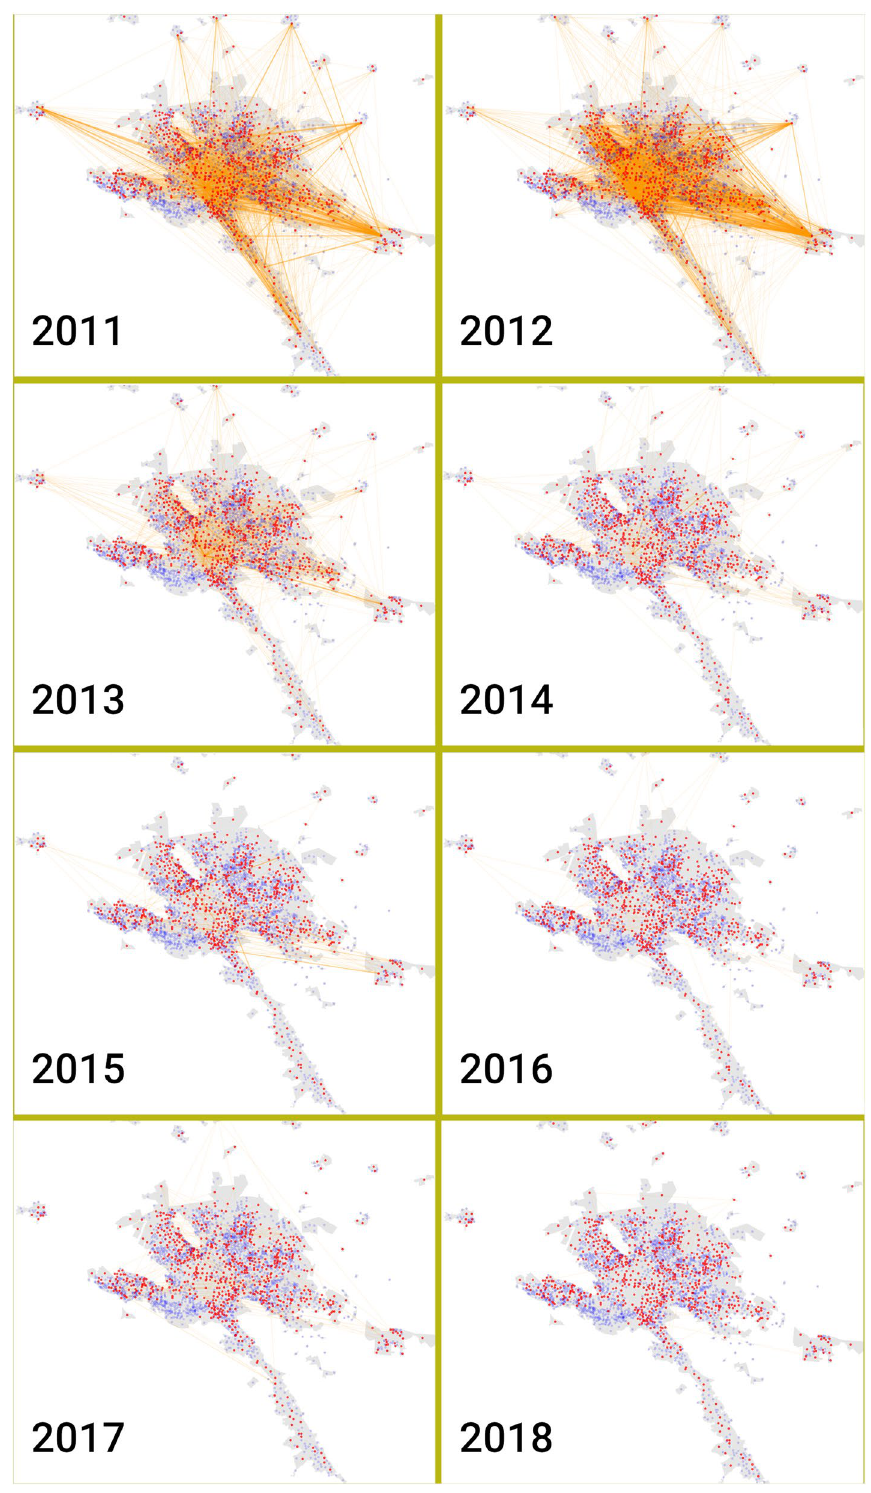
Figure 7. Network of homicides in MMA during the eighth years. In this network representation, red dots represent neighborhoods with at least one homicide during the measured year. Blue points are neighborhoods without homicides during the period. Links join those neighborhoods that have at least one homicide in the same